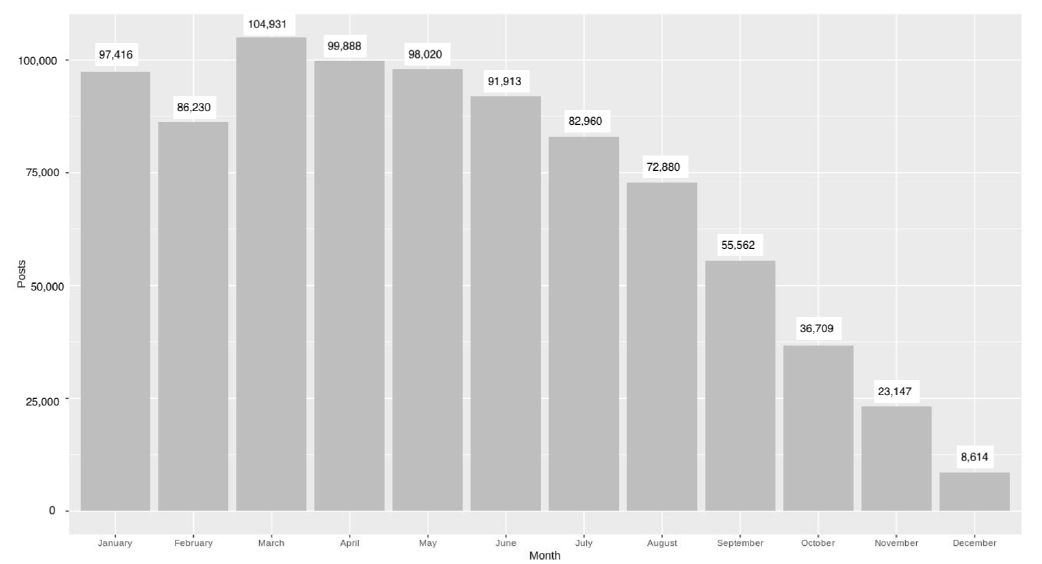
Figure 5. The influence of the time of the year.